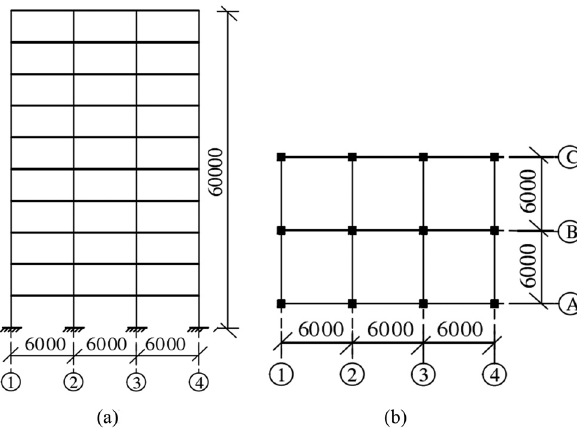
Figure 4: Example framework model. ( a ) Elevation and ( b ) plan.